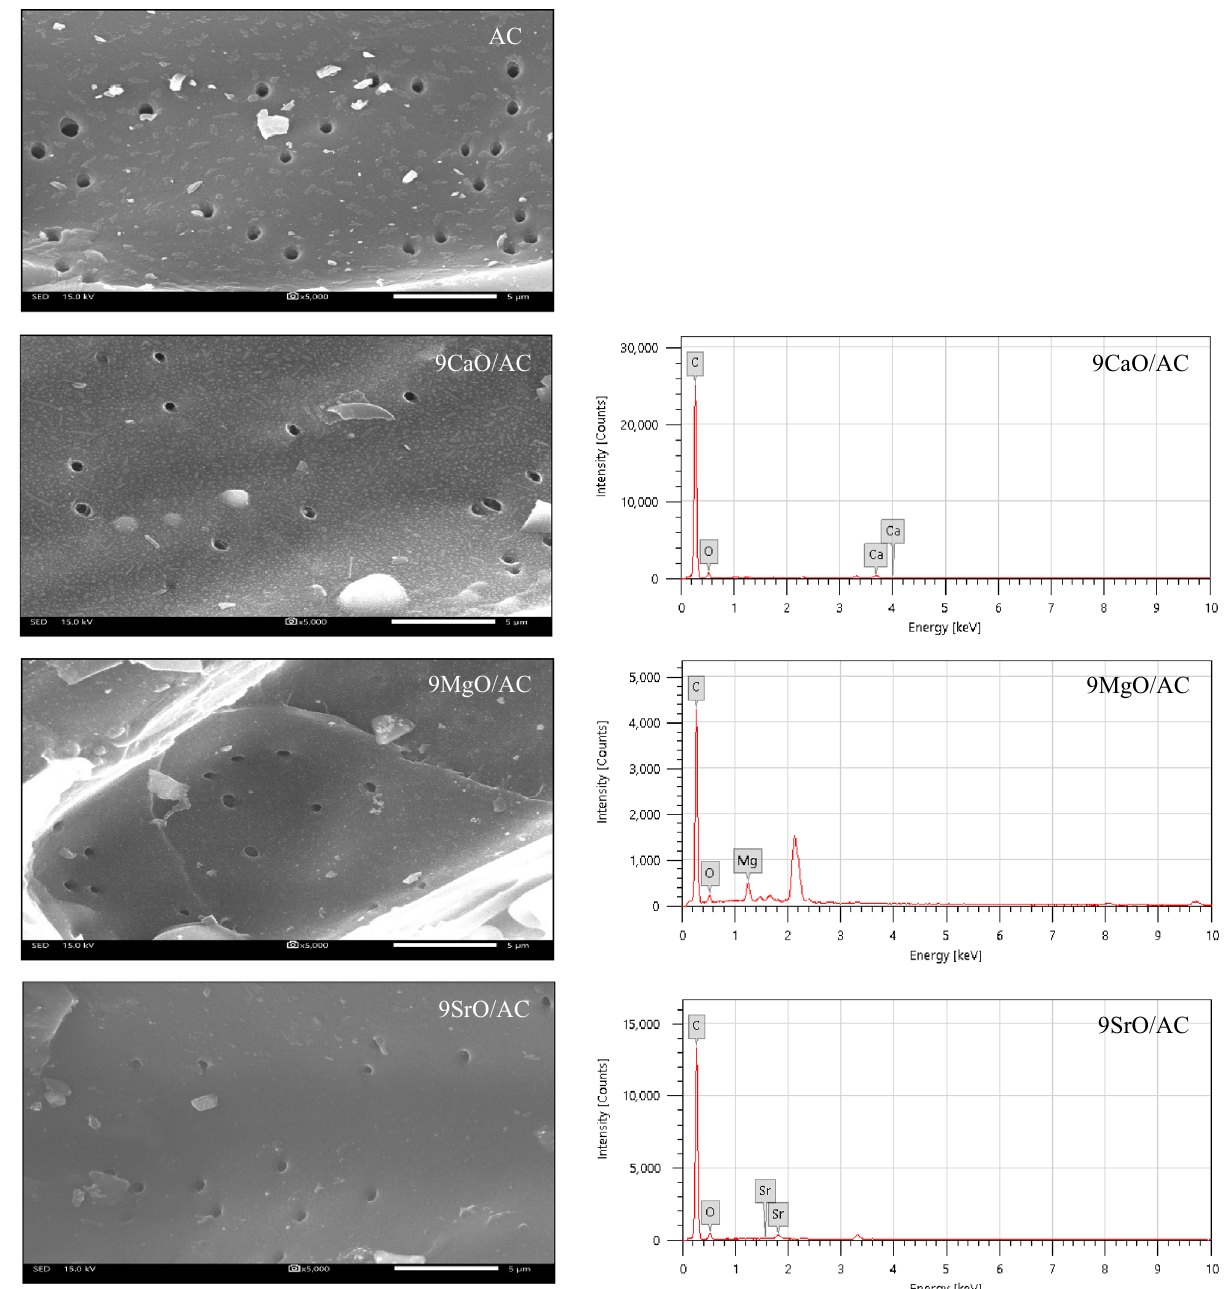
Figure 2. Representative SEM images at magnification of 5000x (left) and EDX (right) of the AC and 9MO/AC